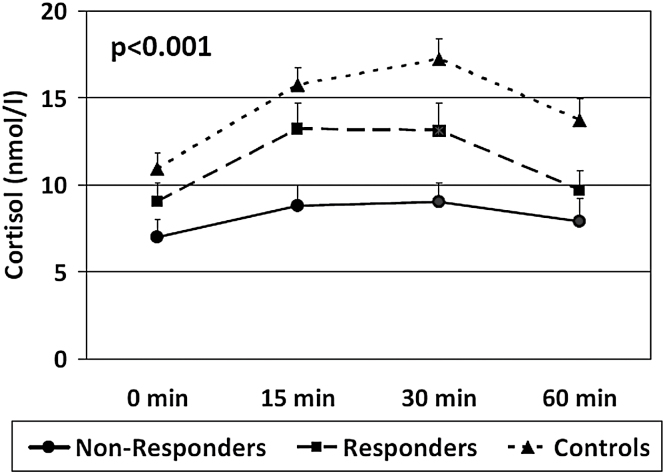
Baseline mean ± standard error of the mean of cortisol levels at 0, 15, 30, and 60min after awakening in Controls, Responders, and Non-Responders. P value indicates the significance of the comparison of the area under the curve of cortisol awakening response at one-way ANOVA.